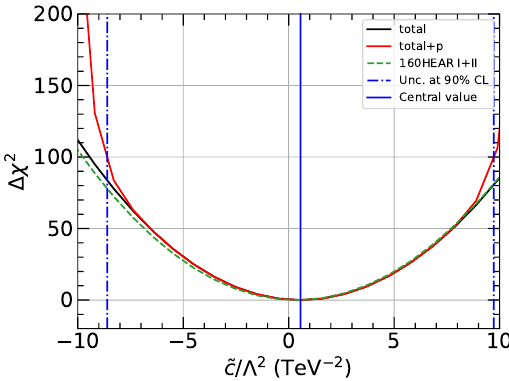
Figure 22 . LM scans on ˜ c/ Λ 2 . The blue vertical solid line represents the central value of ˜ c/ Λ 2 , and the blue vertical dot-dash lines represent the uncertainties at 90%